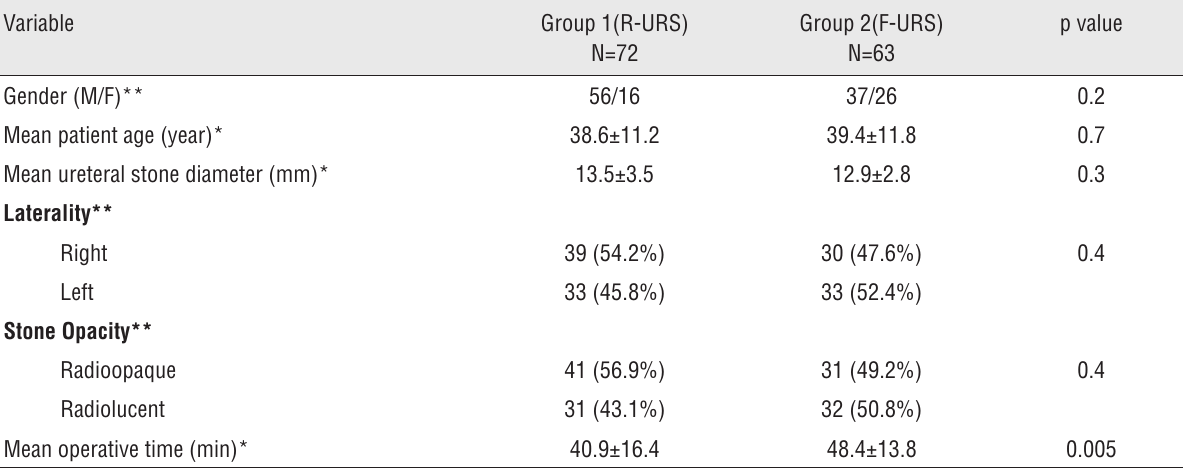
Table 1 - Demographic and clinical characteristics of study groups.